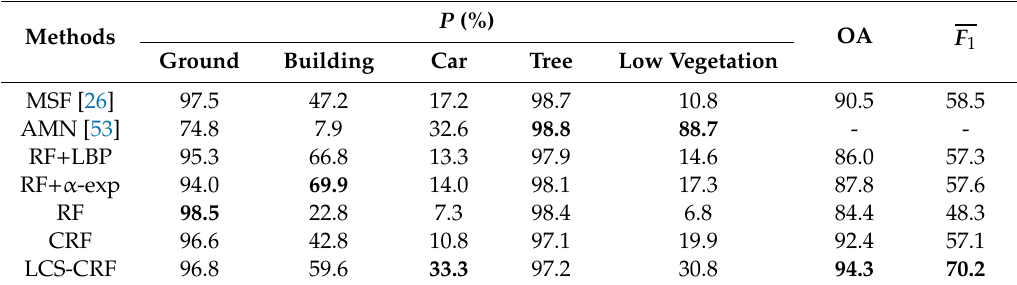
Table 4. Scores per class for each method and corresponding OA and F 1 (%).